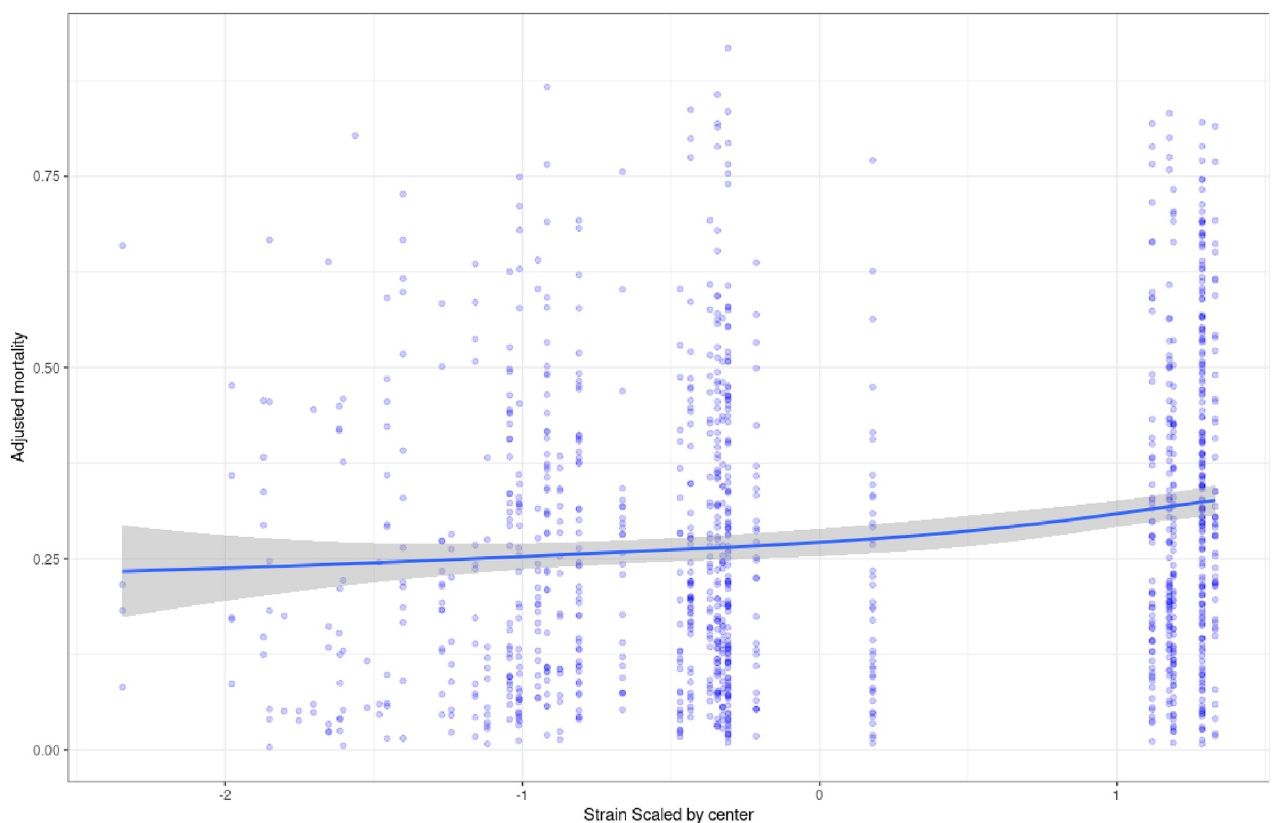
Fig 3. Adjusted predicted mortality as a function of intensive care unit (ICU) strain. ICU strain within center was calculated as follows: (number of COVID-19 admission in each center–mean number of COVID-19 admission in each center during the whole period) / standard deviation of admission in each center. Bold line and gray area represent respectively fit and